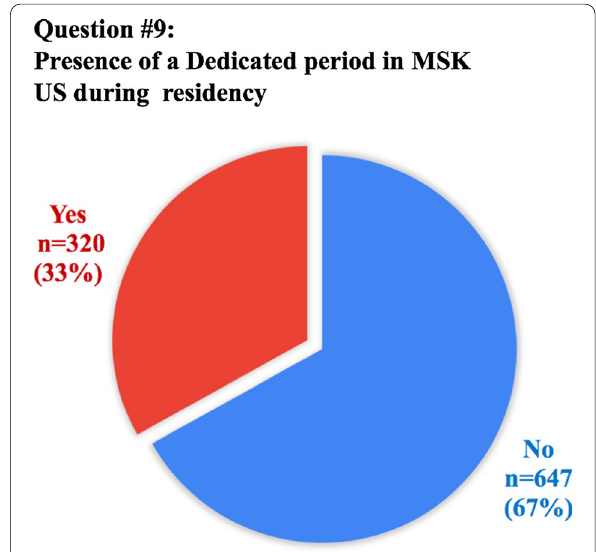
Fig. 2 Graphical representation of answer distribution to question #9: presence of a dedicated period of MSK US